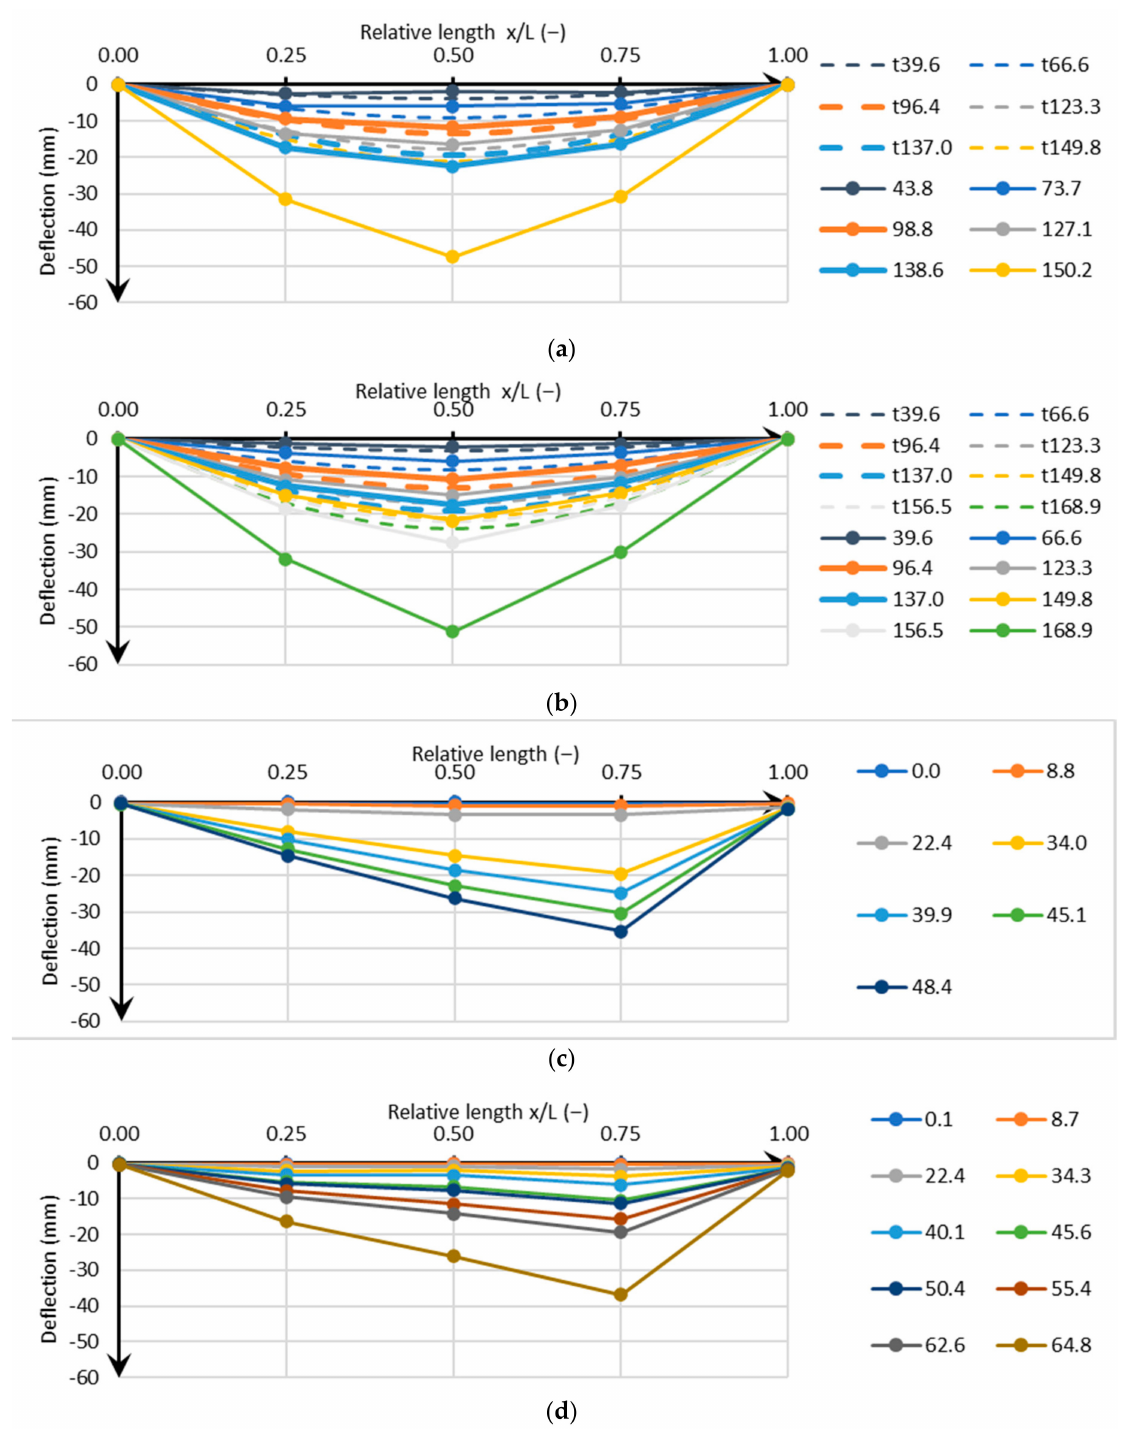
Figure 6. Deformation shape along the longitudinal axis: ( a ) solid slab C02; ( b ) solid slab C04; ( c ) solid slab with Plexi C05 and free rods at the start; ( d ) solid slab with Plexi C06 with fitted